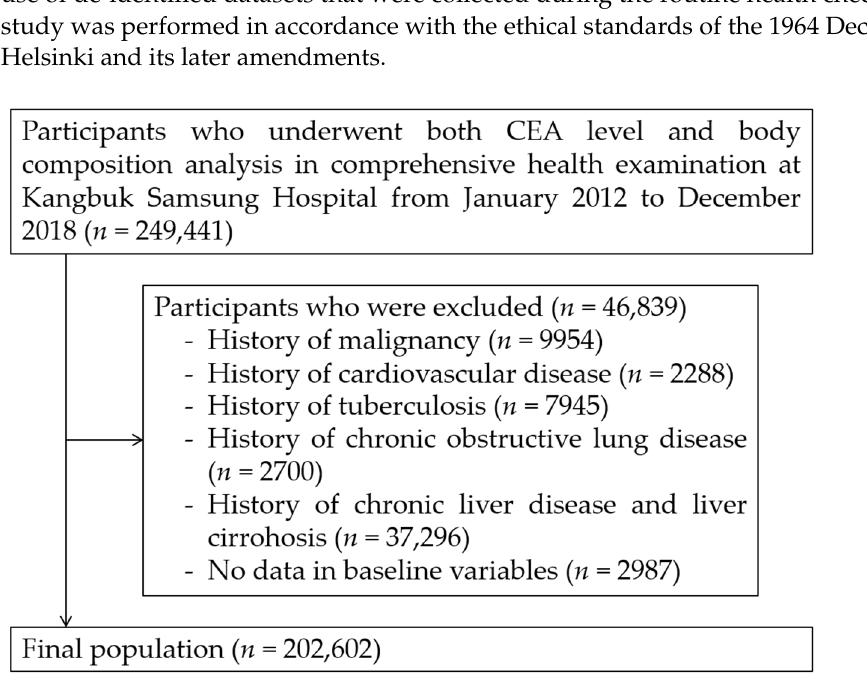
Figure 1. Selection of study population. CEA: carcinoembryonic antigen.